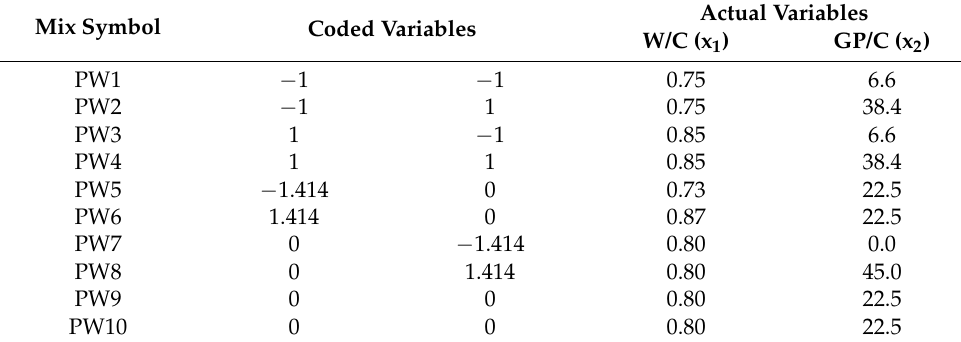
Table 1. List of coded and actual variables.